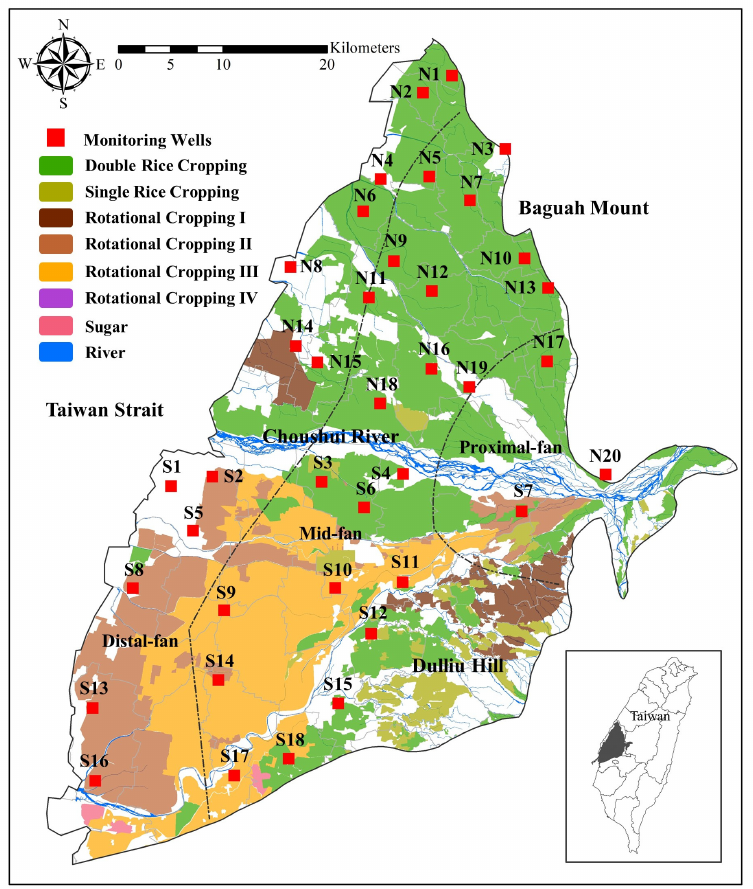
Figure 1. Spatial distribution of monitoring wells and cropping patterns in the Choushui River alluvial fan in Taiwan.